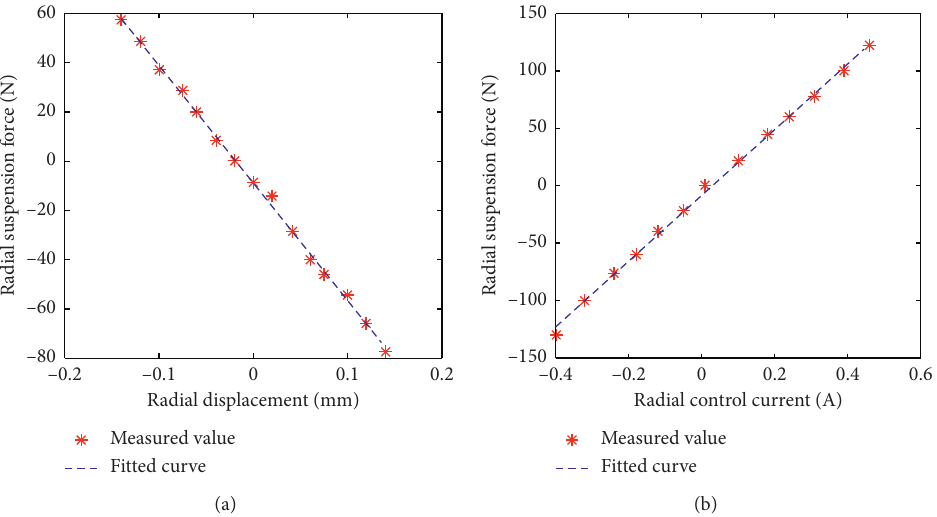
Figure 7: (a) Radial suspension force versus radial displacement. (b) Radial suspension force versus control current.